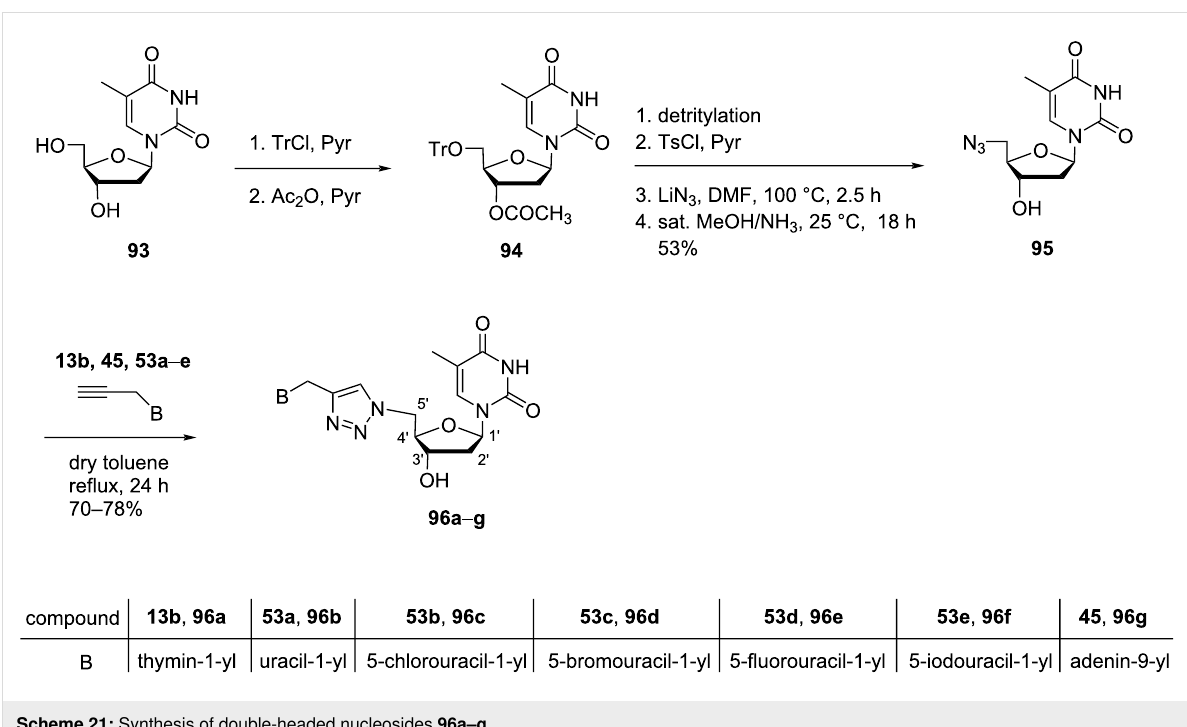
Scheme 21: Synthesis of double-headed nucleosides 96a–g